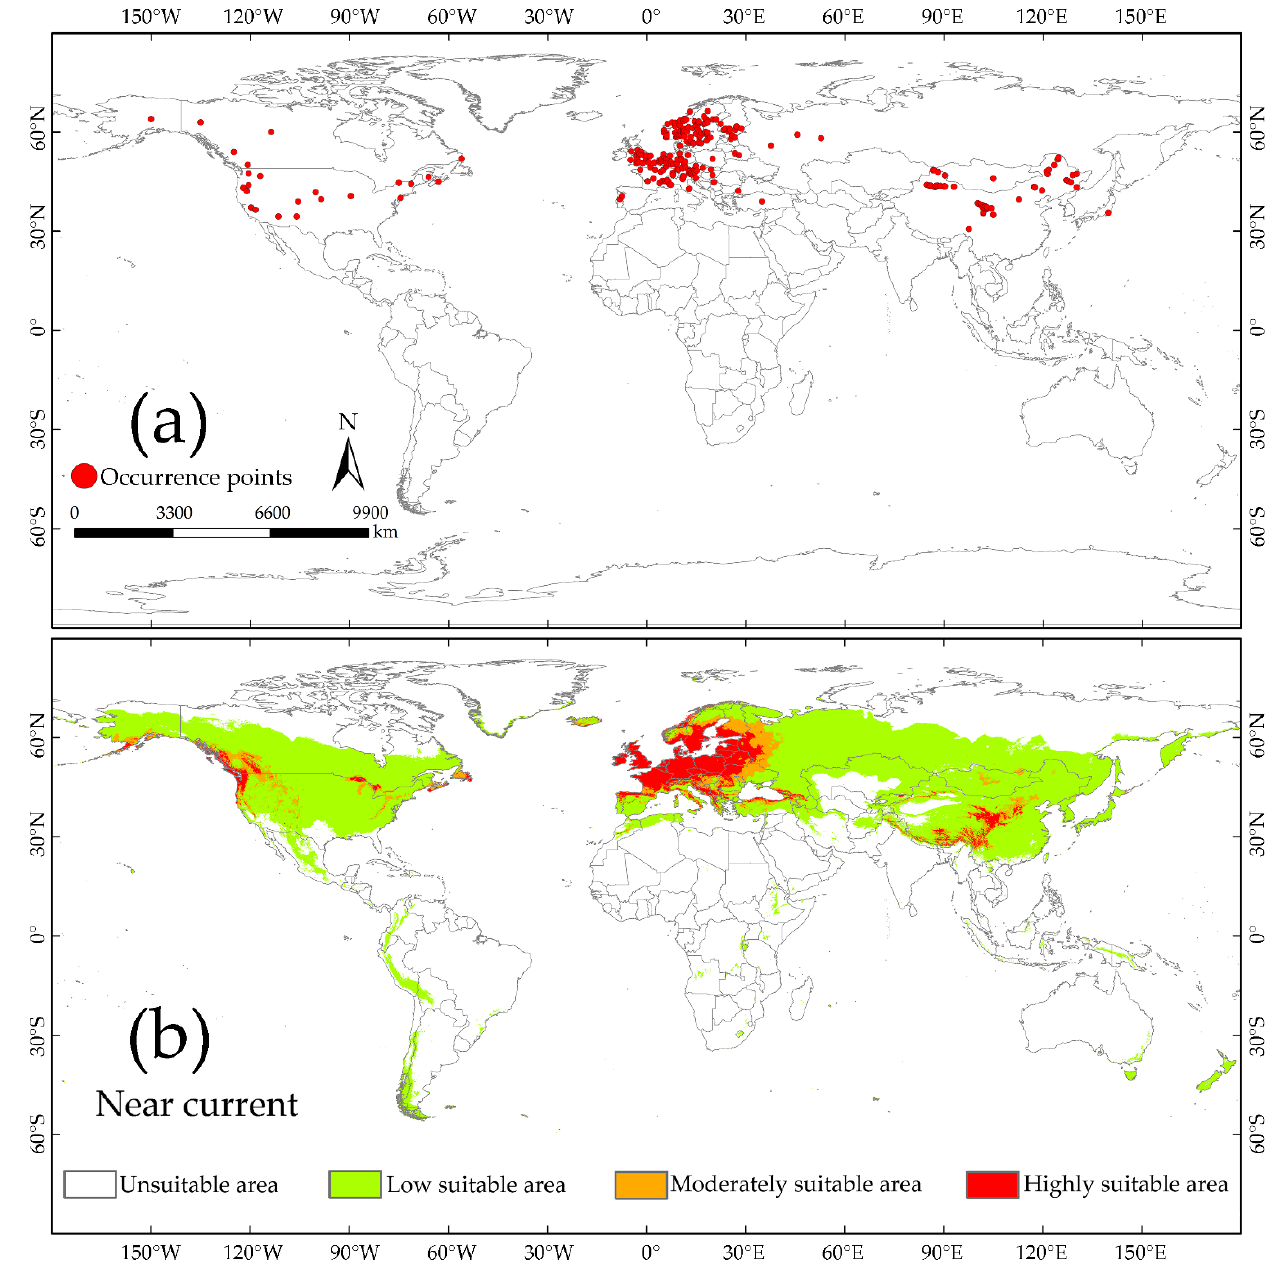
Figure 3. ( a ) Current occurrence and global distribution of S. juvencus ; ( b ) The predicted area suitability under the near current climate condition. S. juvencus has the potential to occupy over 33.55% of the land area of the world except for the unsuitable continent, Antarctica, which shows high suitability for the occurrence of S. juvencus .